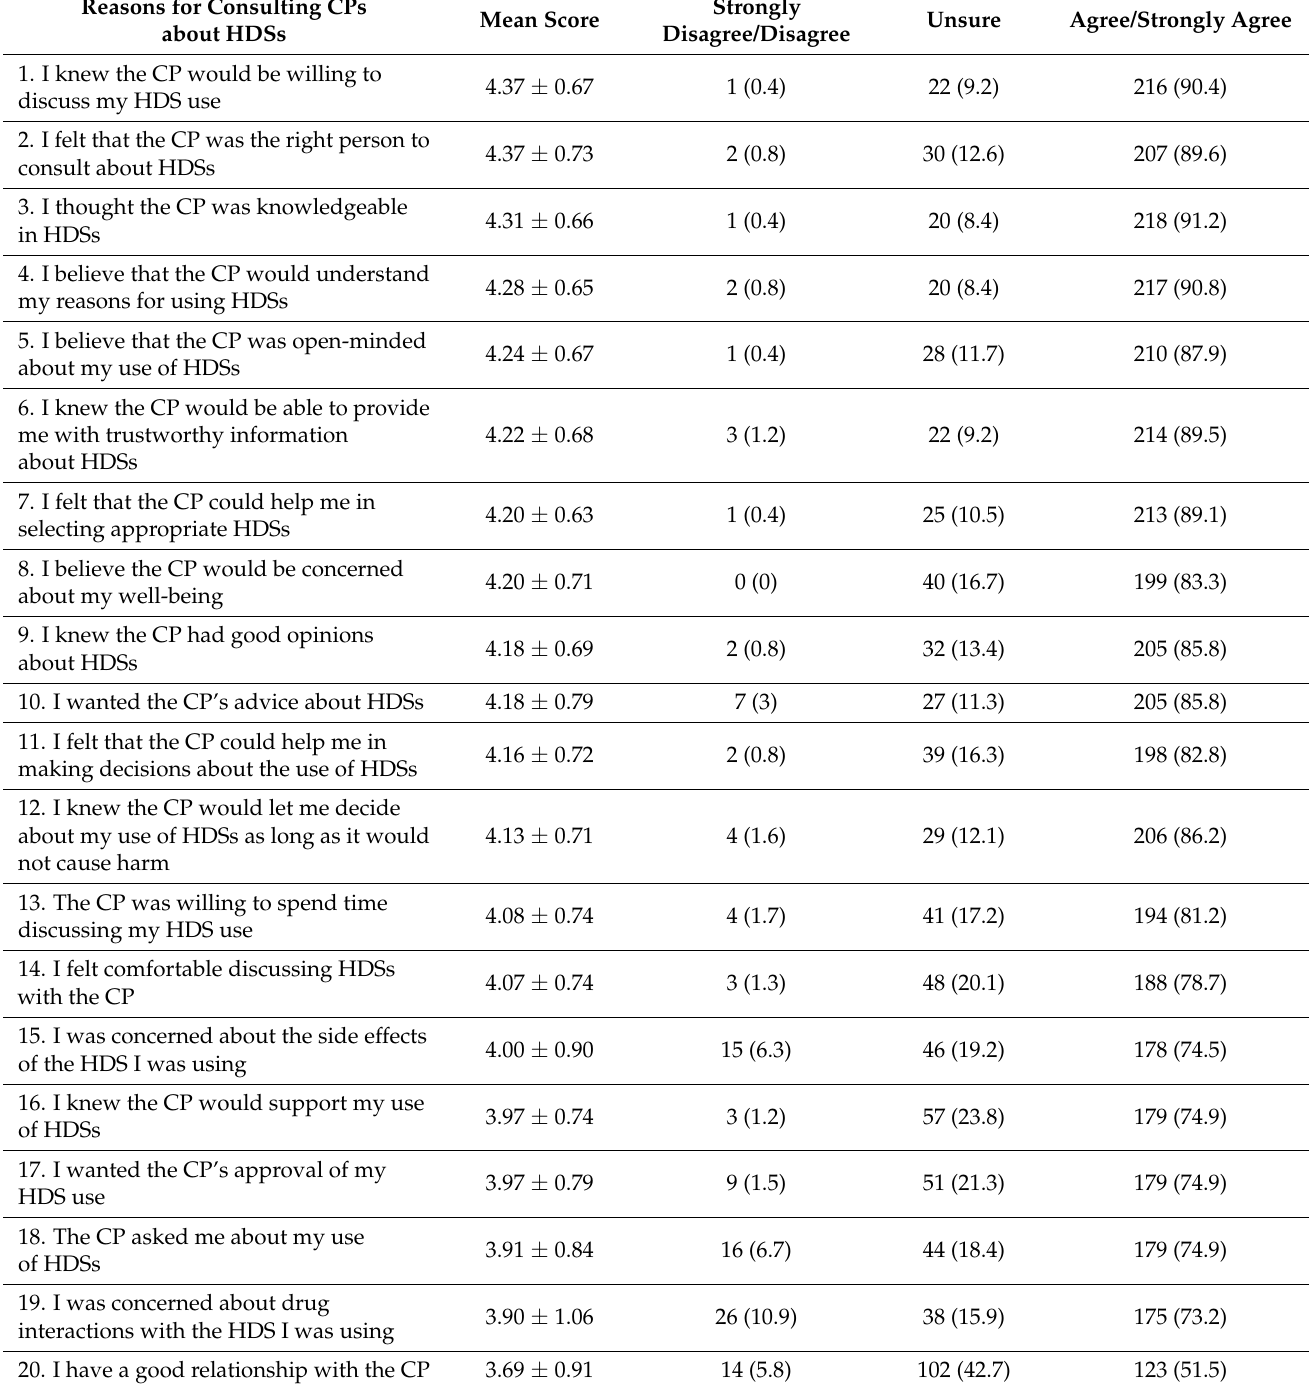
Table 3. The reasons for consulting CPs about HDSs ( n =